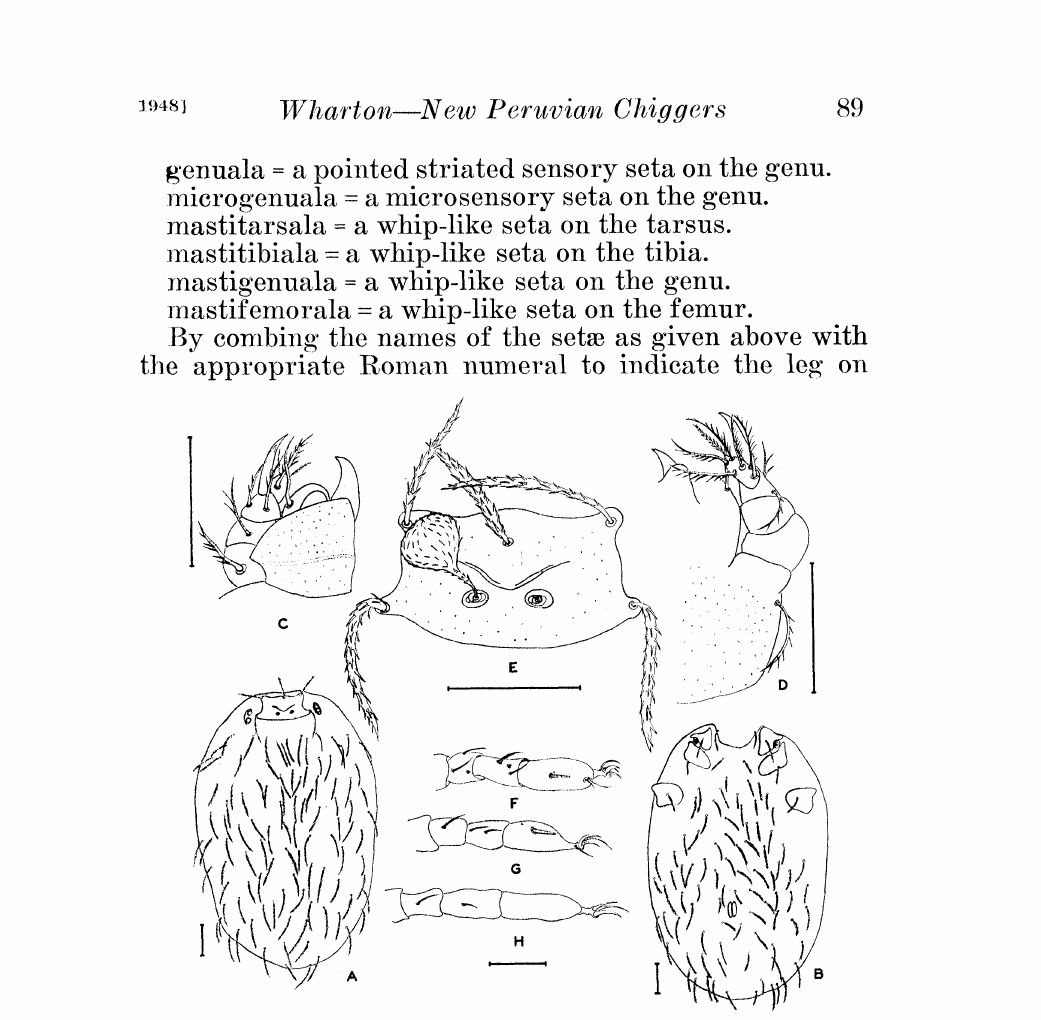
Fig. 1. EuschSngastia phylloti n. sp. A, dorsum; B, venter; C dorsal view of gnathosoma; D, ventral view of gnathosoma; E, scutum; F leg I with specialized sete o2 genu tibia tarsus and prctarsus; G, similar view of leg II; G similar view of leg III. (Magnification of each figure, indi- ca.ted by the line associated with the figure, represents 50